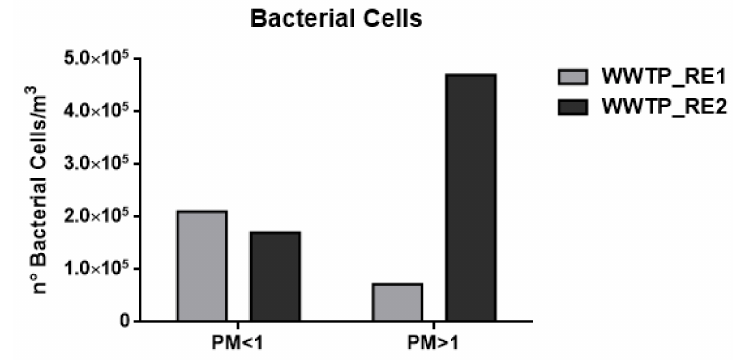
Figure 2. Number (n ◦ ) of total bacterial cell / m 3 in the wastewater treatment plant (WWTP). Sampling campaign WWTP_RE1 (first period) and WWTP_RE2 (second